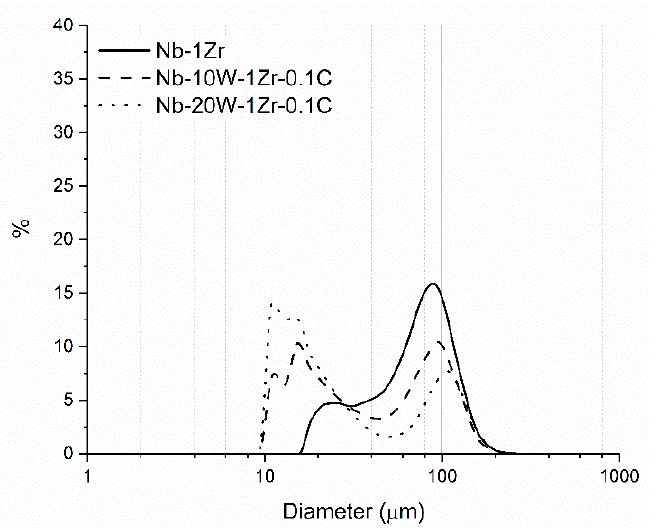
Figure 5. Numerical powder size distribution of the Nb-1Zr and blended Nb-W-Zr-C bimodal pow-